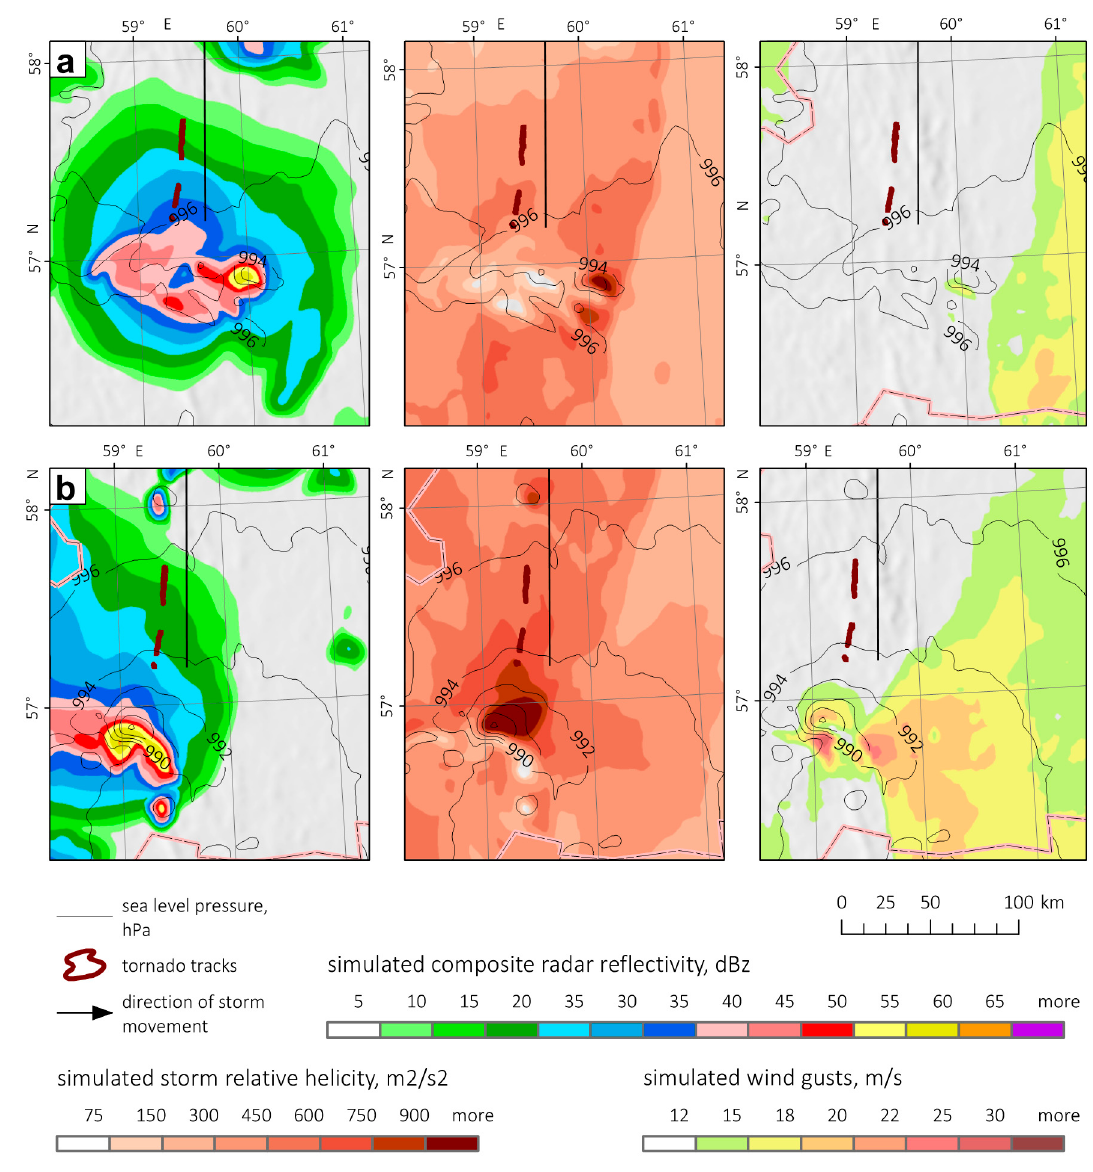
Figure 13. WRF-simulated composite reflectivity (dBz), storm-relative helicity (m 2 s − 2 ), and wind gusts at 1200 UTC 3 June 2017 with the different forecast lead time: ( a ) model start time at 0000 UTC 2 June 2017 (the 36-h lead time) and ( b ) model start time at 1200 UTC 2 June 2017 (the 24-h lead time).